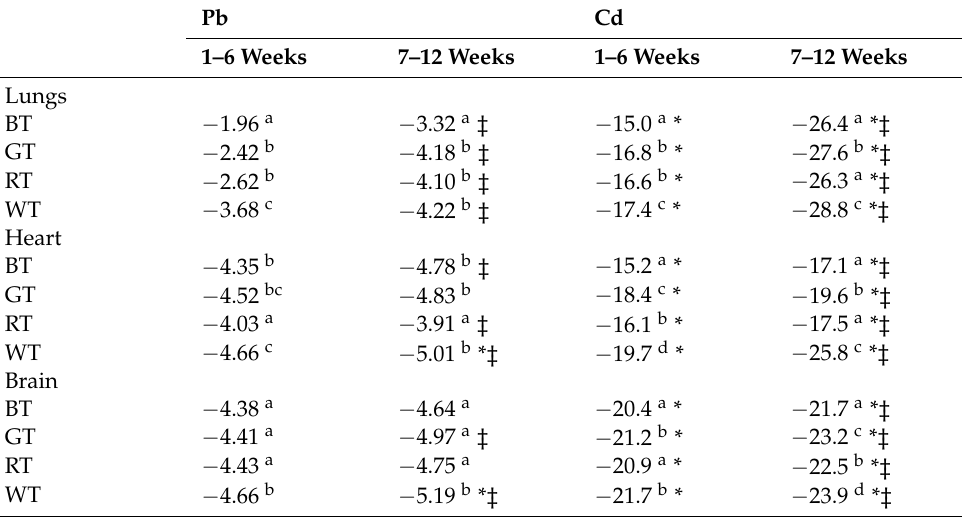
Figure 4. Experiment 2—The distribution of Pb and Cd in the lungs, heart and brain for 6 and 12 weeks of exposure (mean ± SD). SD—standard deviation; * significant versus 0% TA ( p < 0.05). Table 7. Experiment 2—The degree of reduction in absorbing Pb and Cd in the lungs, heart and brain (for 6 and 12 weeks of exposure) compared with the Control group,%. The value of Control group was assumed as 100%.